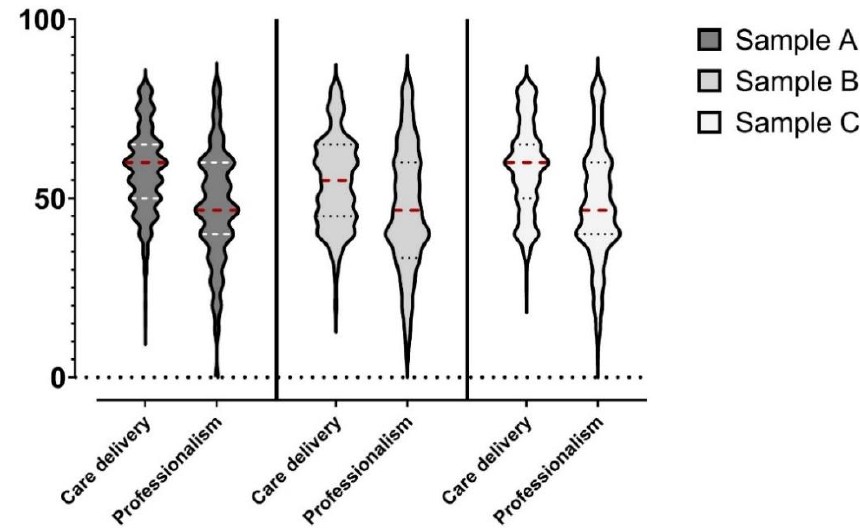
Figure 1. Violin plots describing the computed scores of the NPSES2 in each sample.